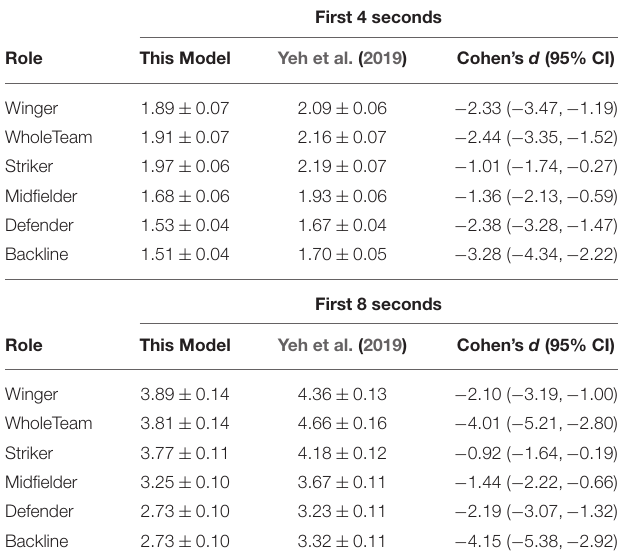
TABLE 1 | Average ℓ 2 -distances and SE between observed and simulated